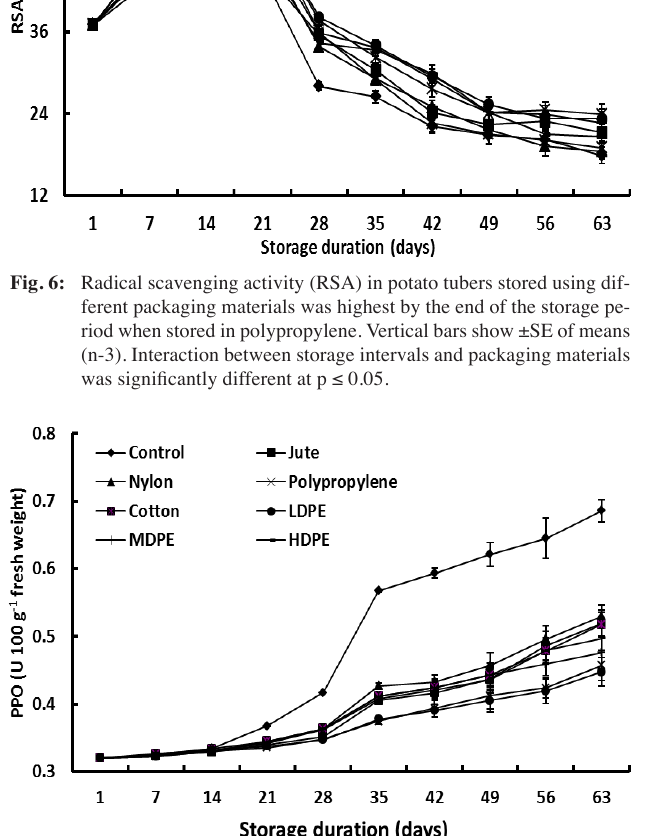
Fig. 7: Polyphenol oxidase (PPO) in potato tuber stored in different pa- ckaging materials was lowest by the end of the storage period when stored in polypropylene and LDPE. Vertical bars show ±SE of means (n-3). Interaction between storage intervals and packaging materials was significantly different at p ≤ 0.05.